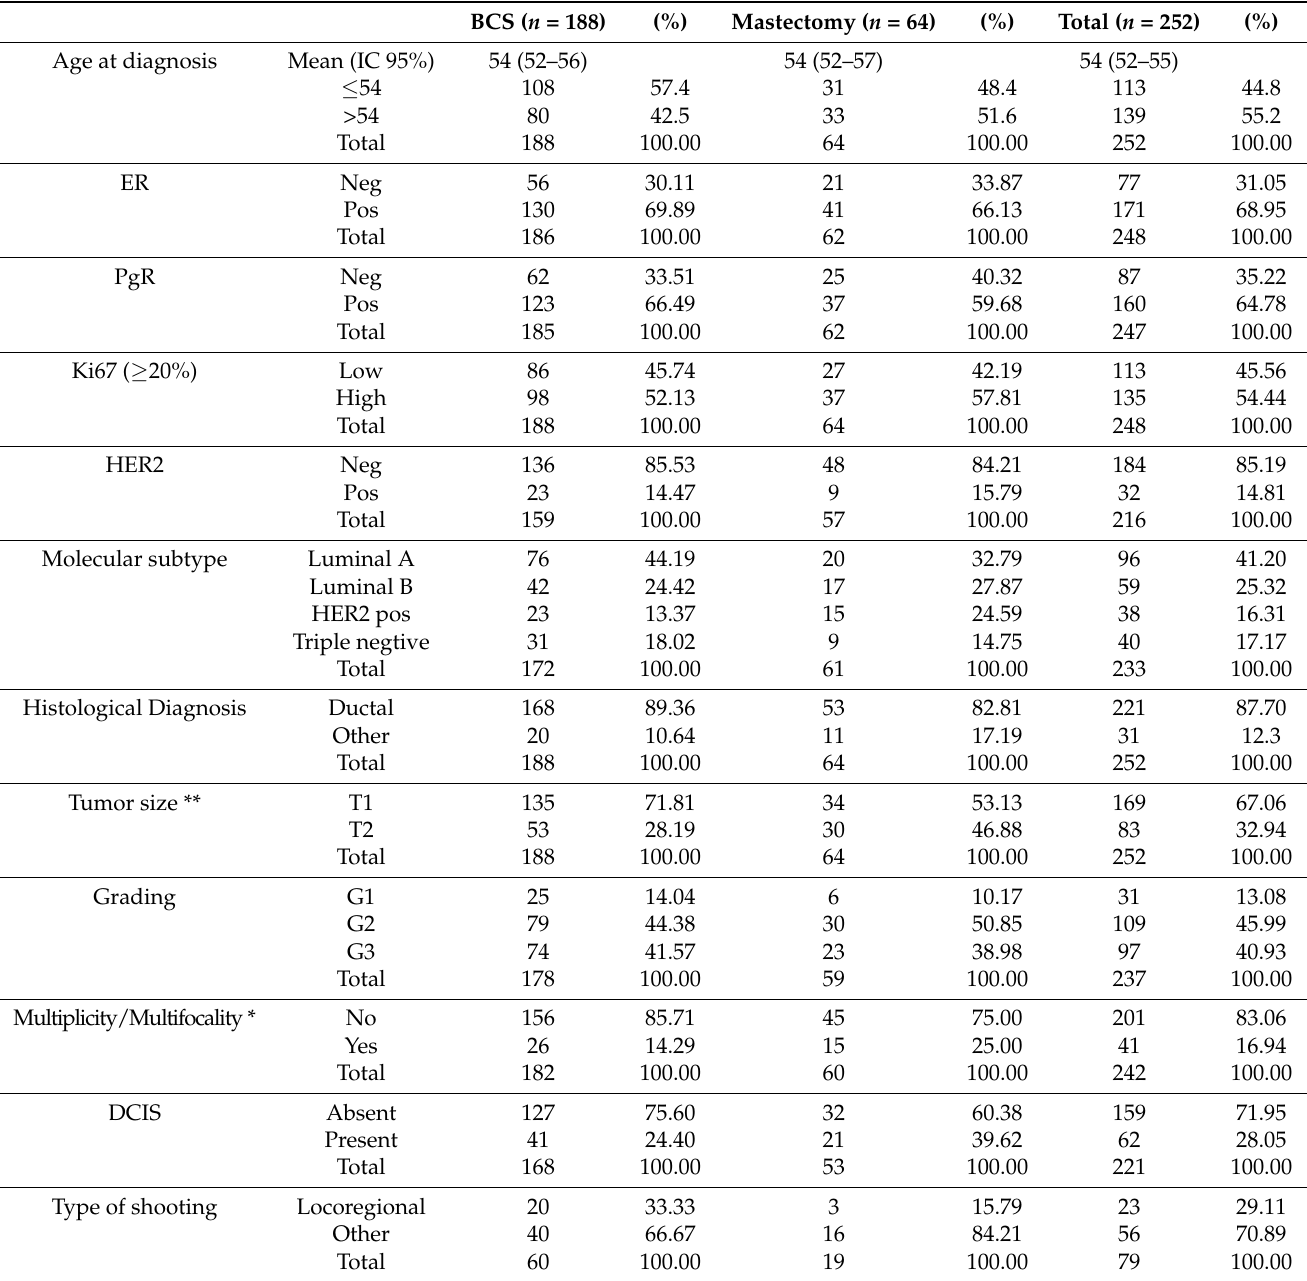
Table 1. Characteristics of the total collected data ( n = 252) as well as separate characteristics of patients treated with BCS ( n = 188) and mastectomy ( n =